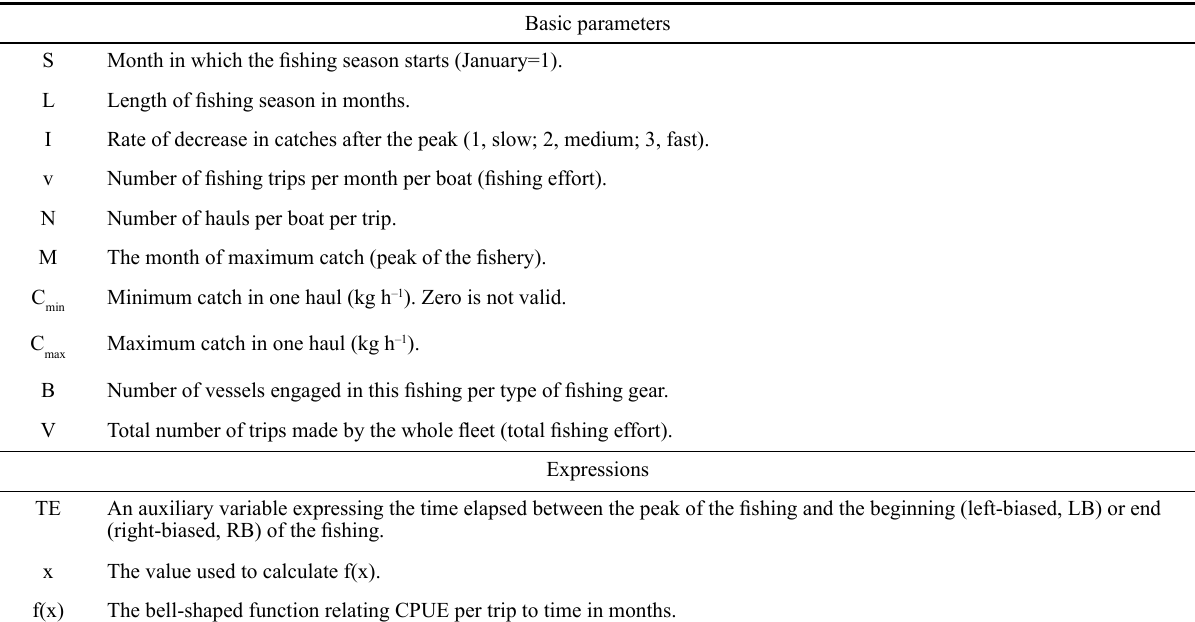
t.Table 1. – Parameters and expressions used in the Gómez-Muñoz (1990)